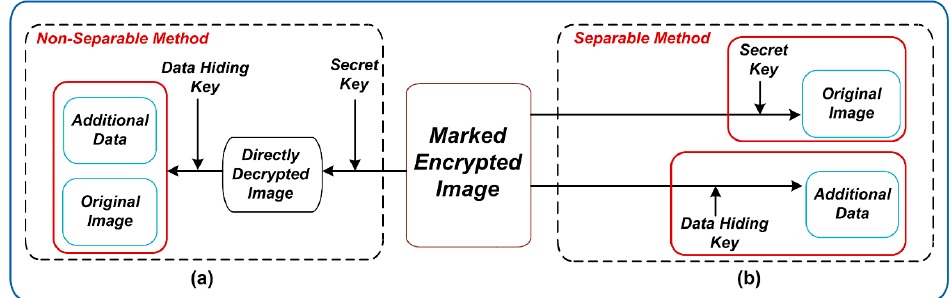
Figure 1. ( a ) Non-separable; and ( b ) separable methods in reversible data hiding.